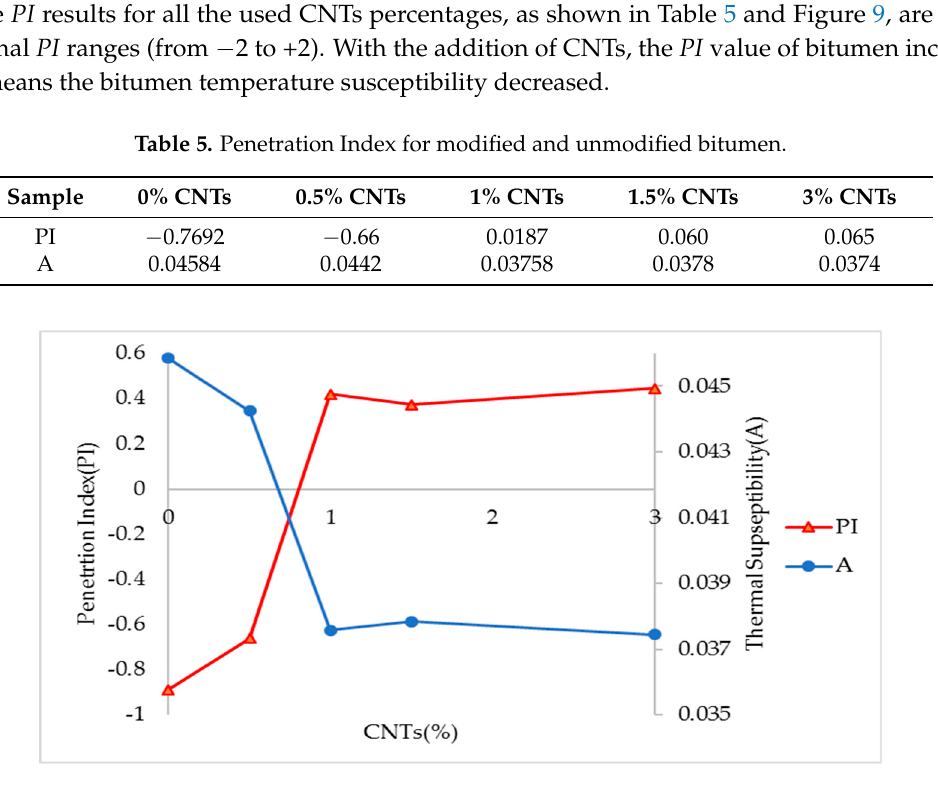
Figure 9. Effect on Penetration Index and Thermal Susceptibility with addition of CNTs.